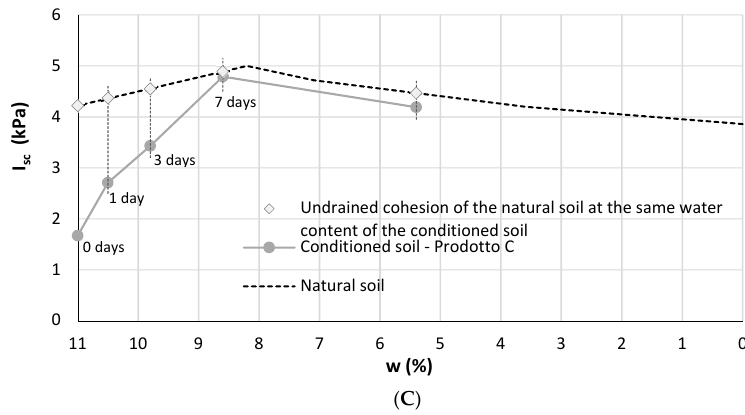
Figure 5. Results of vane test for products A, B and C. ( A ) Results of vane test for products A, ( B ) Results of vane test for products B ; ( C ) Results of vane test for products C.